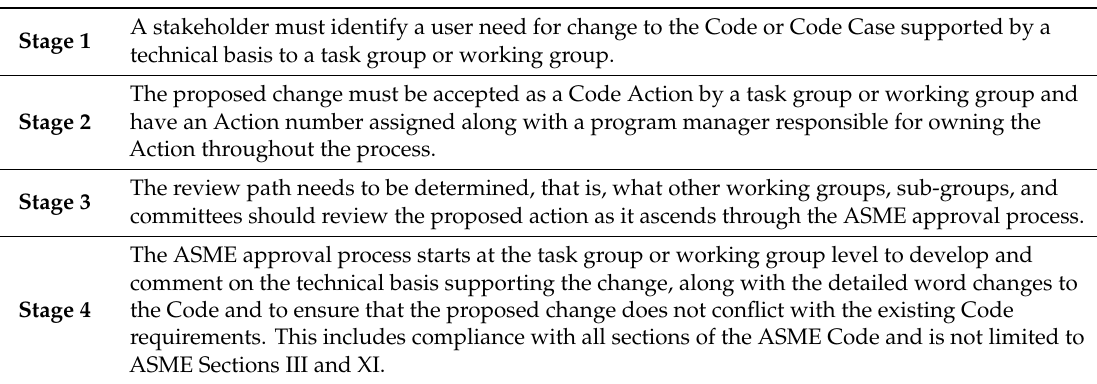
Table 5. Summary of Code Case development processes.